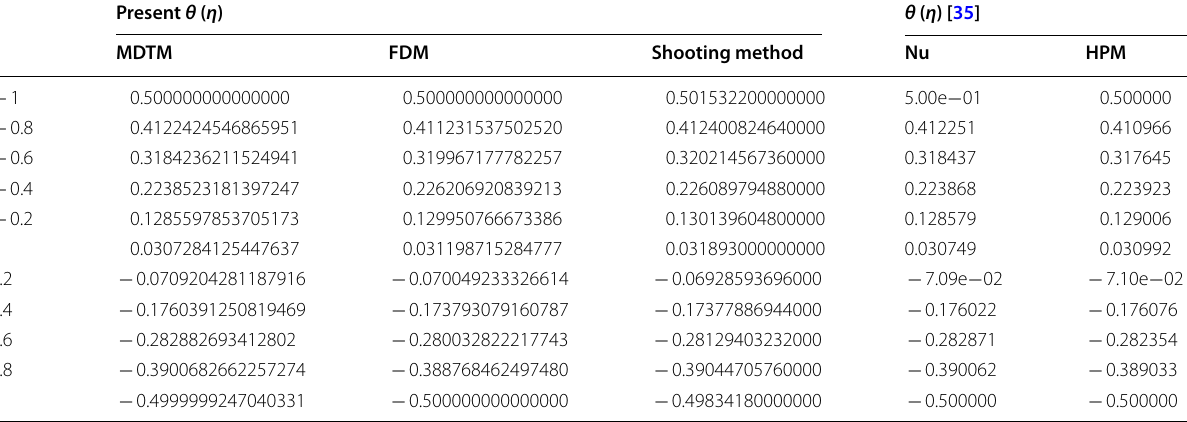
Table 7 Comparison solution by MDTM, FDM, and shooting method with Nu and HPM [35] for θ ( η ) when ϕ Ha 0, 1 R 0, Ec 2, Pr 6.2, and α d = = = = =